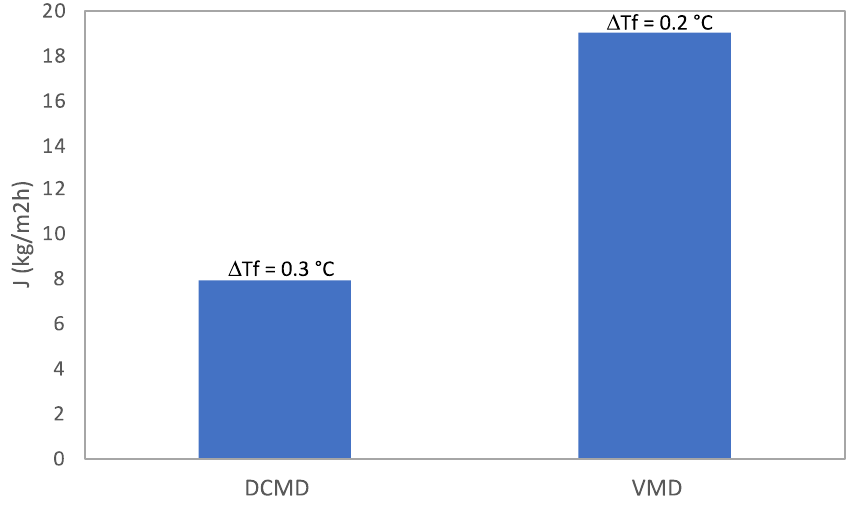
Figure 4. Trans-membrane flux and feed temperature variation for the two MD units.